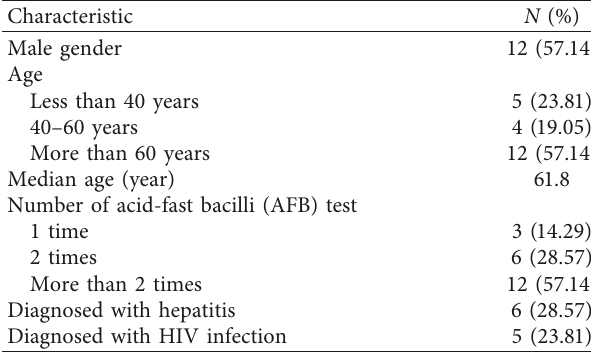
Table 1: Baseline characteristics of patients received levofloxacin- based regimens as empirical treatment for tuberculosis ( N �